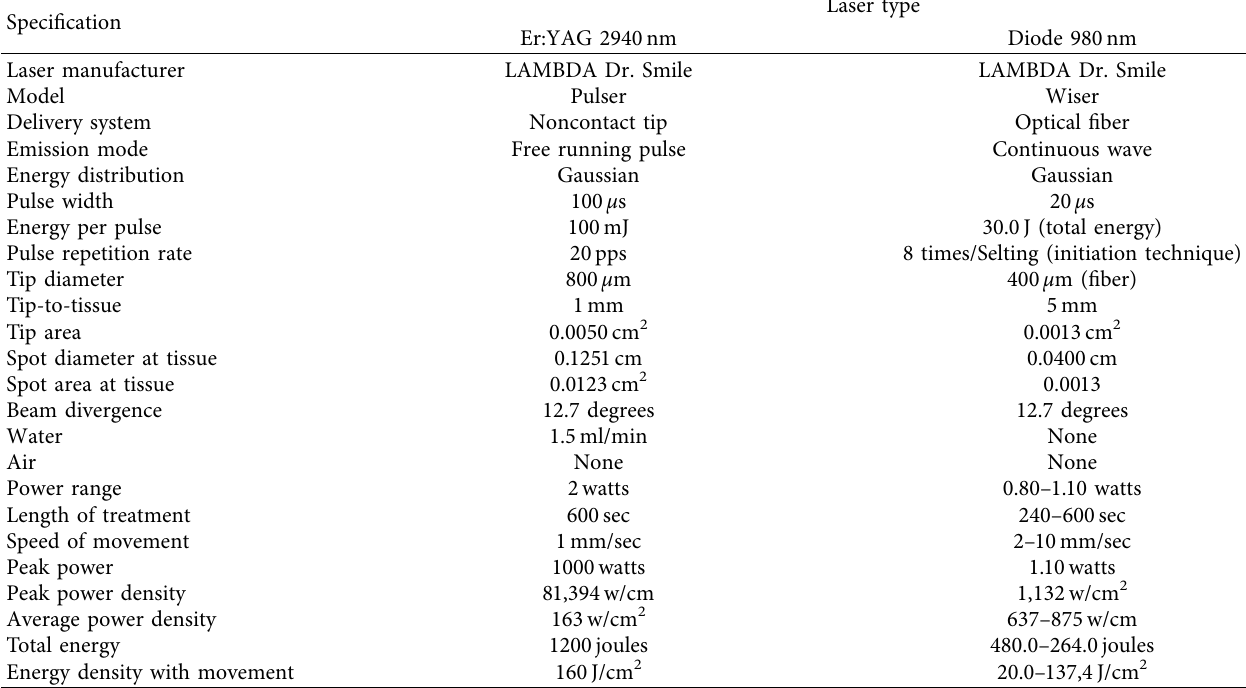
Table 1: Er:YAG 2940nm and diode 980nm laser parameters and specifications.